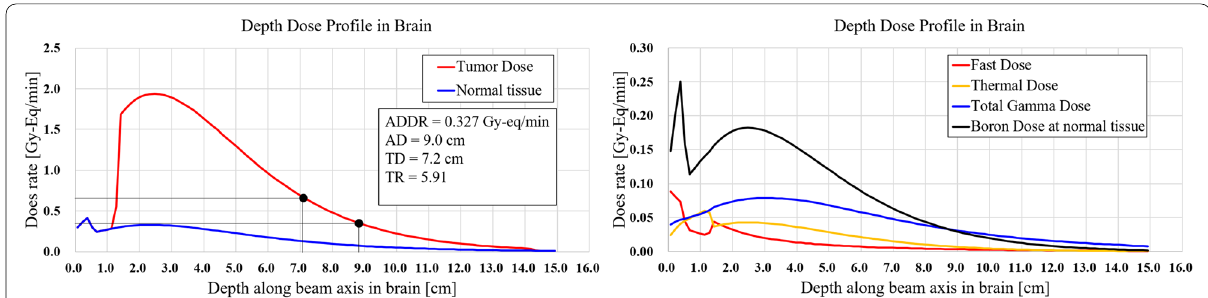
Fig. 18 In‑depth dose rate profiles for the brain (Snyder head model) along the beam axis. The left figure is for the total dose rates of tumor and normal tissues. The right figure is for dose rate components of the fast neutron, thermal neutron, total γ radiation, and boron dose at the normal